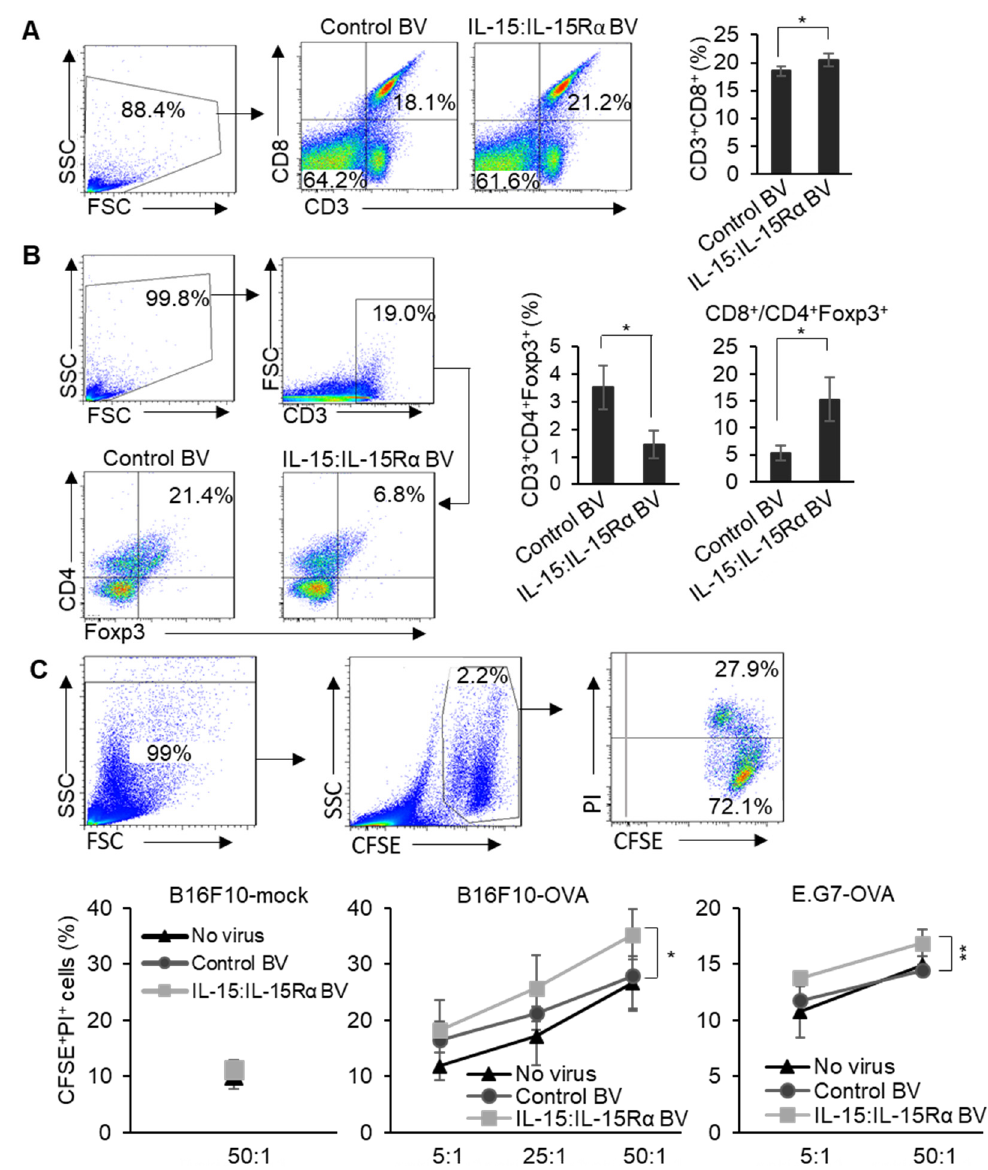
Figure 5. The IL-15:IL-15R α -B16F10-OVA vaccine enhanced cytotoxicity of OVA-specific CD8 + T cells. Mice were immunized as shown in Figure 3A ( n = 4~5). On day 22 after challenging with live B16F10-OVA cells, splenocytes from the tumor-bearing mice were collected and stimulated with OVA peptides, SIINFEKL, and IL-2 (20 U/mL) for 72 h in vitro. ( A ) The stimulated splenocytes were analyzed for CD3 + CD8 + . ( B ) CD3 + CD4 + Foxp3 + (Treg cells) and the ratio of CD3 + CD8 + to CD3 + CD4 + Foxp3 + were analyzed. ( C ) The OVA peptide-stimulated splenocytes and CFSE-labeled target cells (B16F10-mock, B16F10-OVA, E.G7-OVA) were mixed at the ratios of 5:1, 25:1, and 50:1. The percentages of CFSE + PI + cells (dead cells) were analyzed with the flow cytometric analysis. Note: * p < 0.05, ** p < 0.01, B16F10-mock; mock-transfected